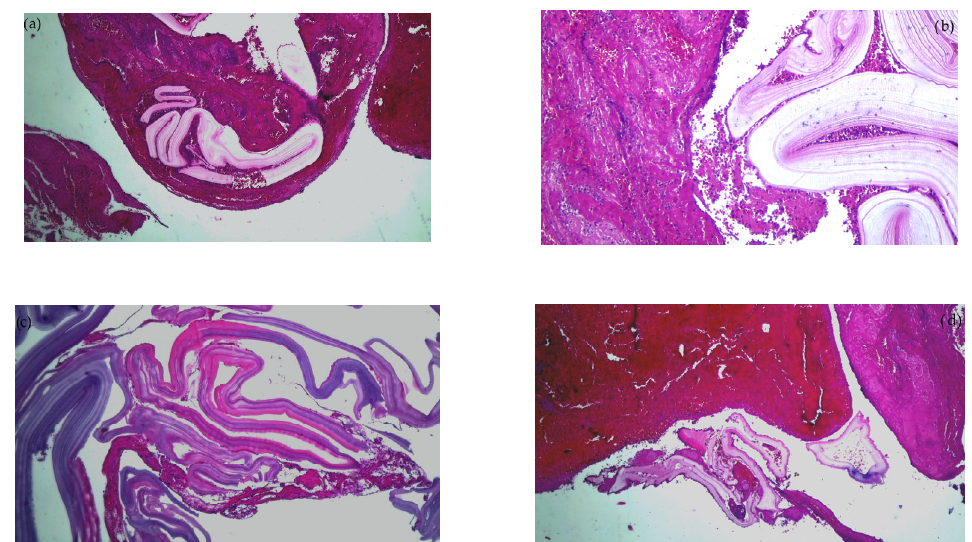
Figure 3. Histopathological examination of the hydatid cyst membrane collected from the brachial artery: ( a ) HE × 40: fibrin clot enclosing fragments of the anhistous membrane; ( b ) HE × 100: anhistous membrane fragment embedded in fibrin-blood clot; ( c ) HE × 40: anhistous membrane fragment; ( d ) Histopathological examination HE × 40: anhistous membrane fragment and blood clot.